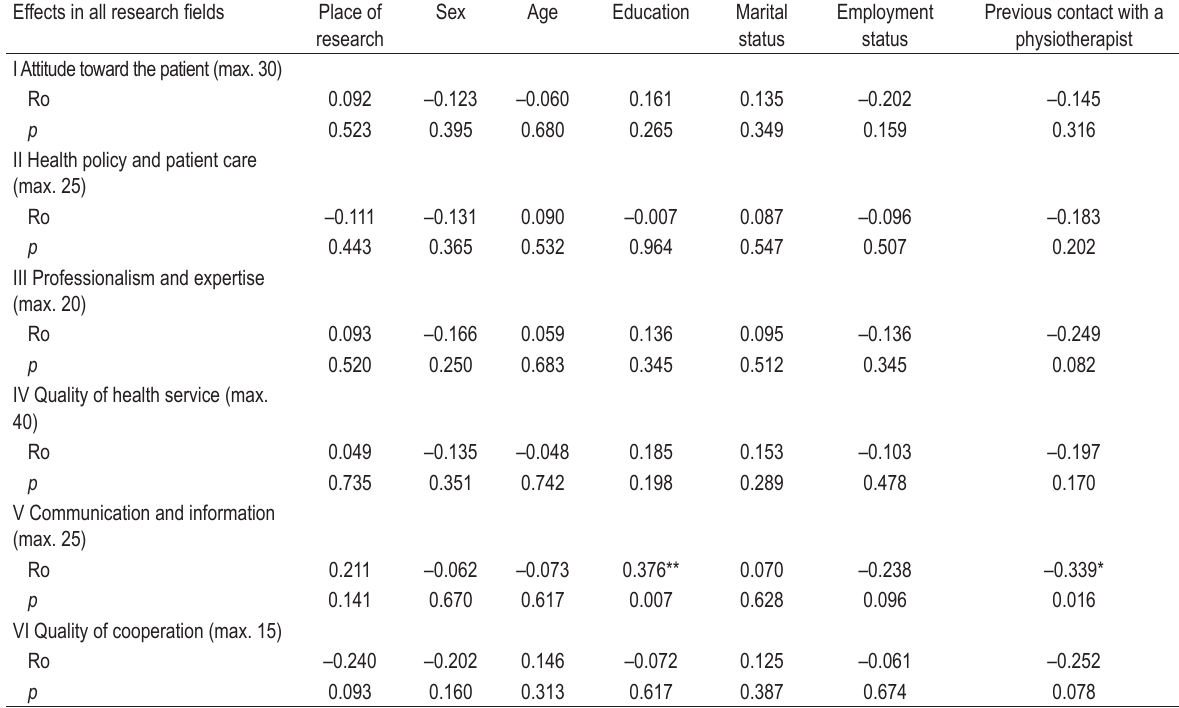
TABLE 8. Correlation analysis of score effects in all research fields